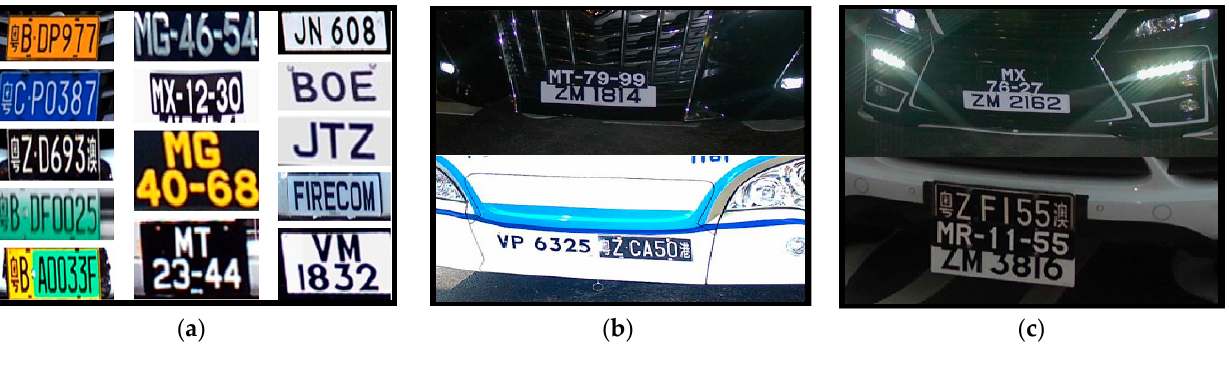
Figure 1. Various license plate challenges.